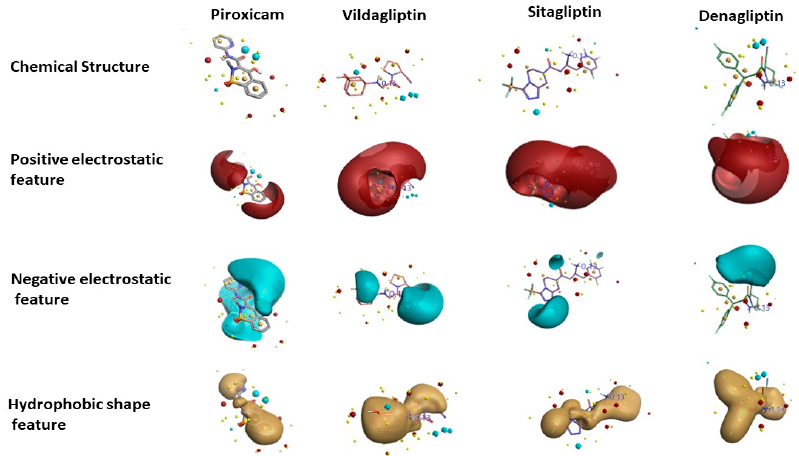
Figure 4. Prediction of piroxicam molecular features: positive electrostatics, negative electrostatics, and hydrophobic shape calculated using XED force field, provided by the Activity Atlas model in comparison with DPP-4 inhibitors in clinical